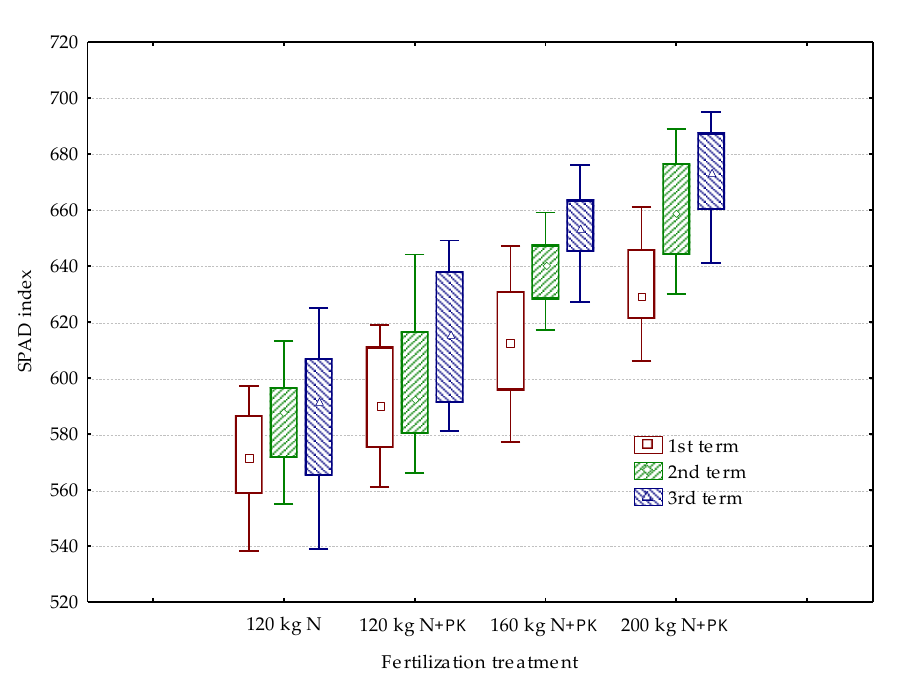
Figure 2. Boxplot of the SPAD index in the following terms of measurements in relation to fertilization treatments. Table 2. The leaf greenness index (SPAD) of two maize varieties depending on the fertilization variant in the first year.